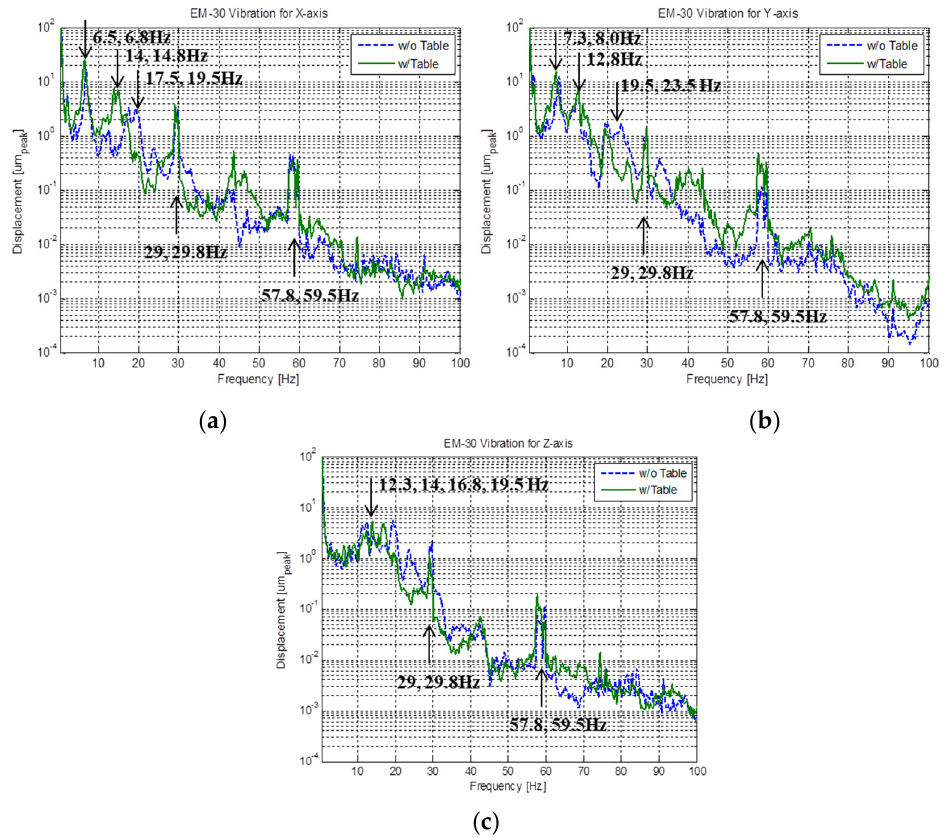
Figure 6. Frequency response functions obtained from vibration measurement in the directions of ( a ) x-axis; ( b ) y-axis; and ( c ) z-axis.